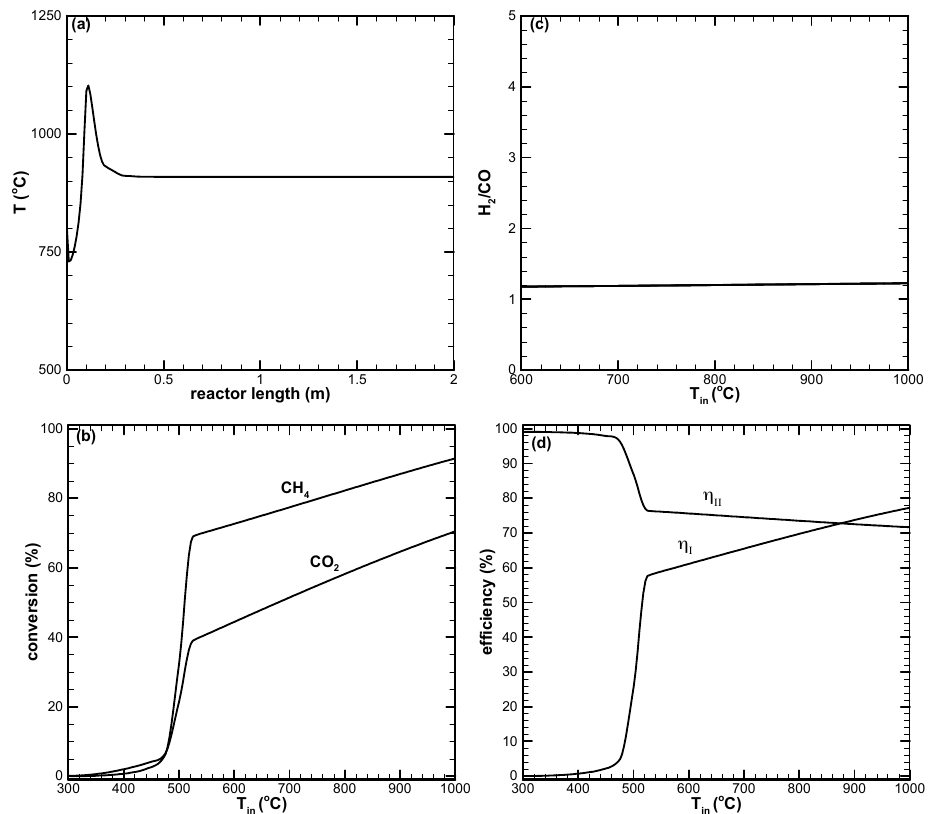
Figure 11. TR process with H 2 O/CH 4 = 0.001 while the other parameters were kept unchanged, as listed in Table 1. ( a ) Temperature variation along reactor with T in = 900 °C; ( b ) CH 4 and CO 2 conversions; ( c ) H 2 /CO ratio; and ( d ) first- and second-law efficiencies.